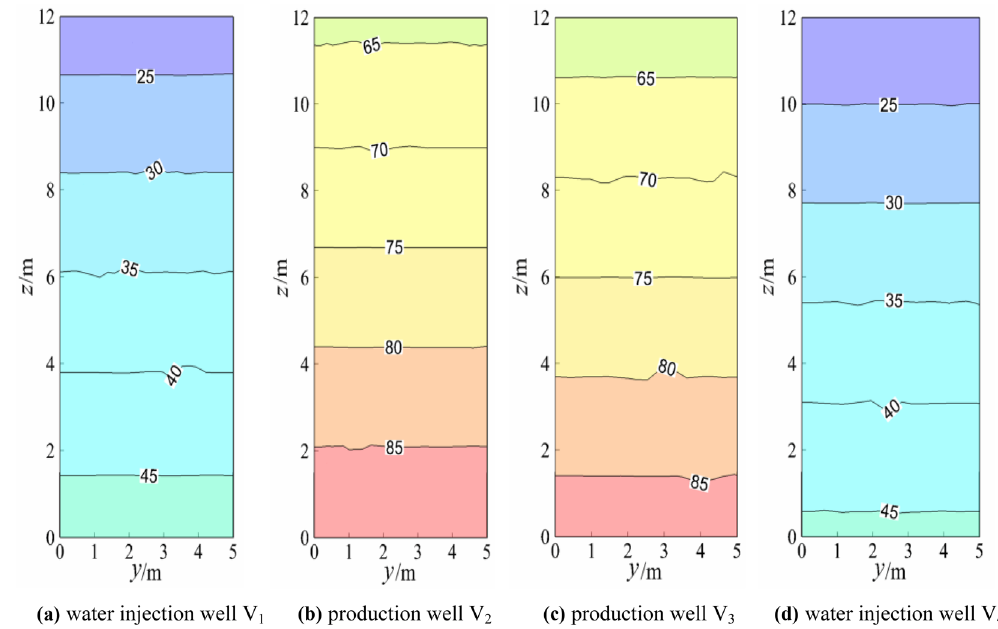
Figure 5. Temperature field of the geothermal well plane (working condition 1).